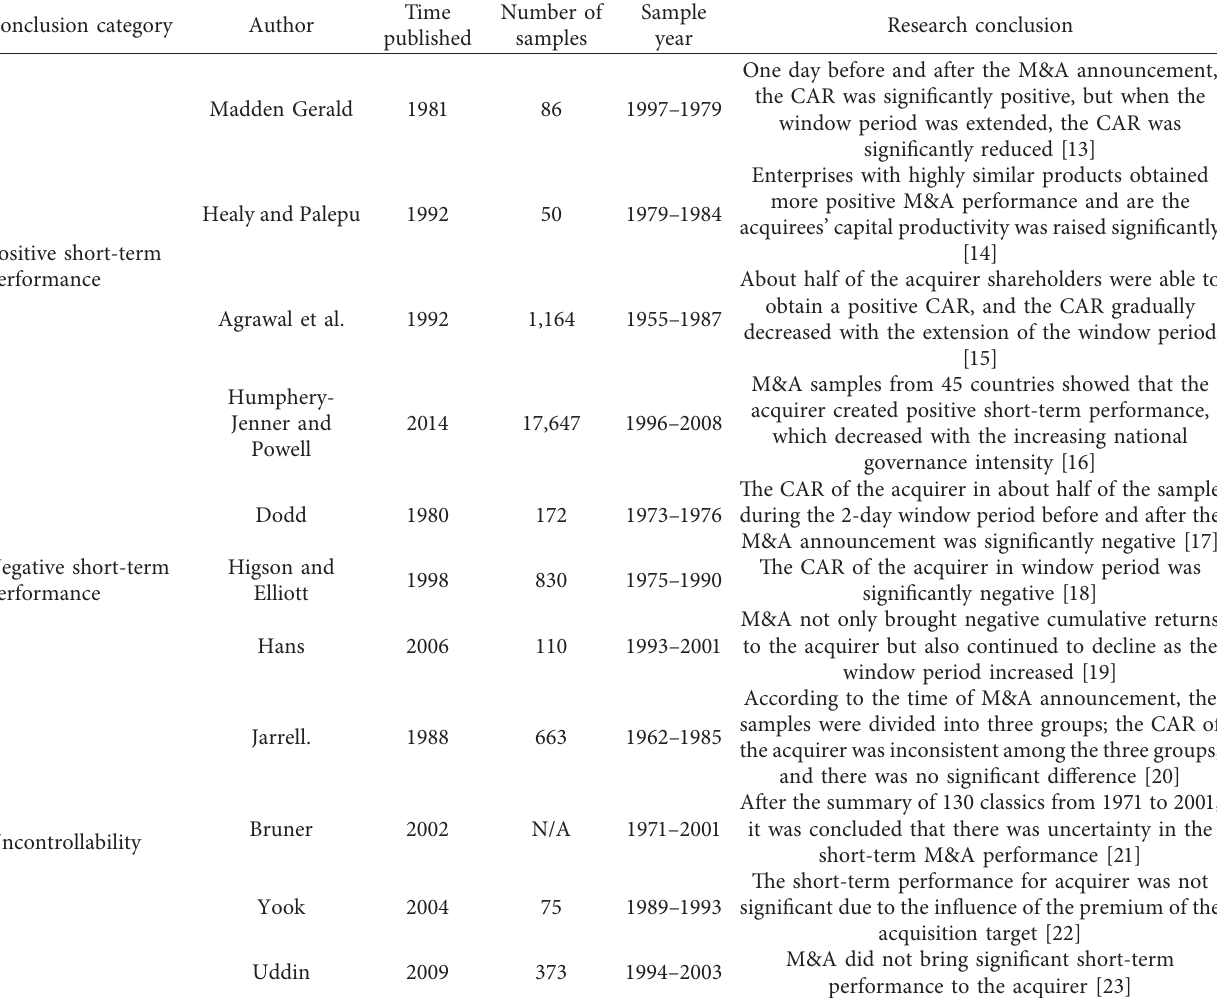
Table 1: Overview of short-term performance research on foreign M&A.